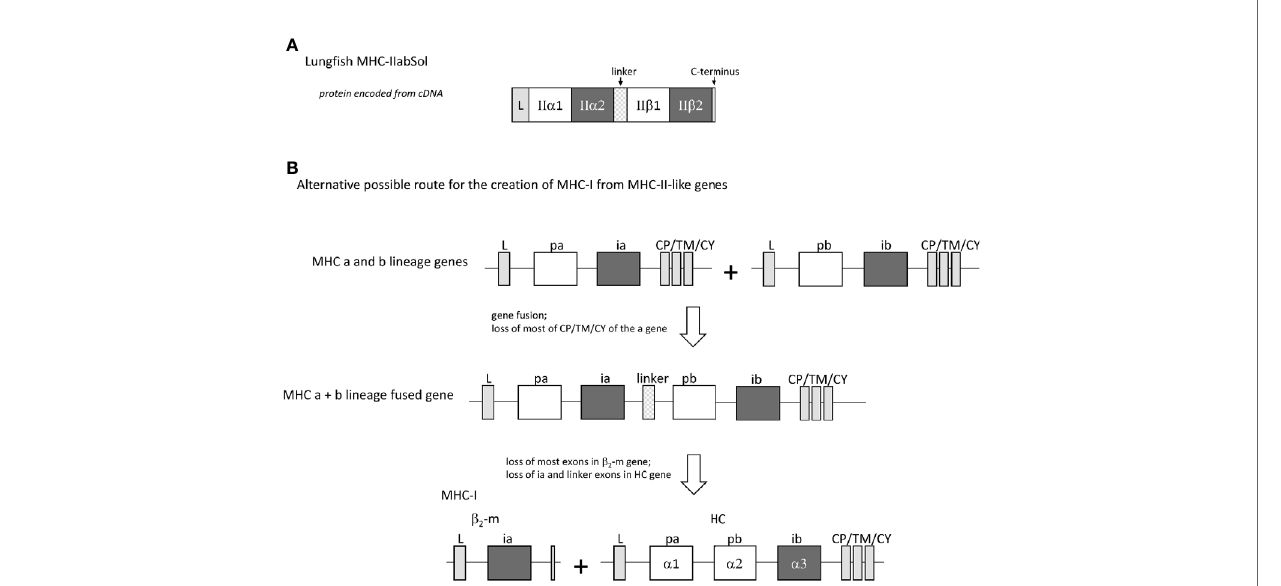
FIGURE 12 | The fi nding of a natural genetic fusion between MHC-II a and MHC-II b in lung fi shes suggest the possibility of a “ II-to-I ” evolution route different from that proposed by Kaufman et al. (20, 21). (A) In lung fi shes, transcripts encoding MHC-IIabSol were identi fi ed, comprising a leader sequence, MHC-II a 1 and a 2 domains, a linker, MHC-II b 1 and b 2 domains, and a short C-terminus (for sequences see Supplementary File 4A ). (B) A genetic fusion combining the four MHC- II a -like and MHC-II b -like ectodomain exons may have been an intermediate in the creation of MHC-I from MHC-II-like ancestral